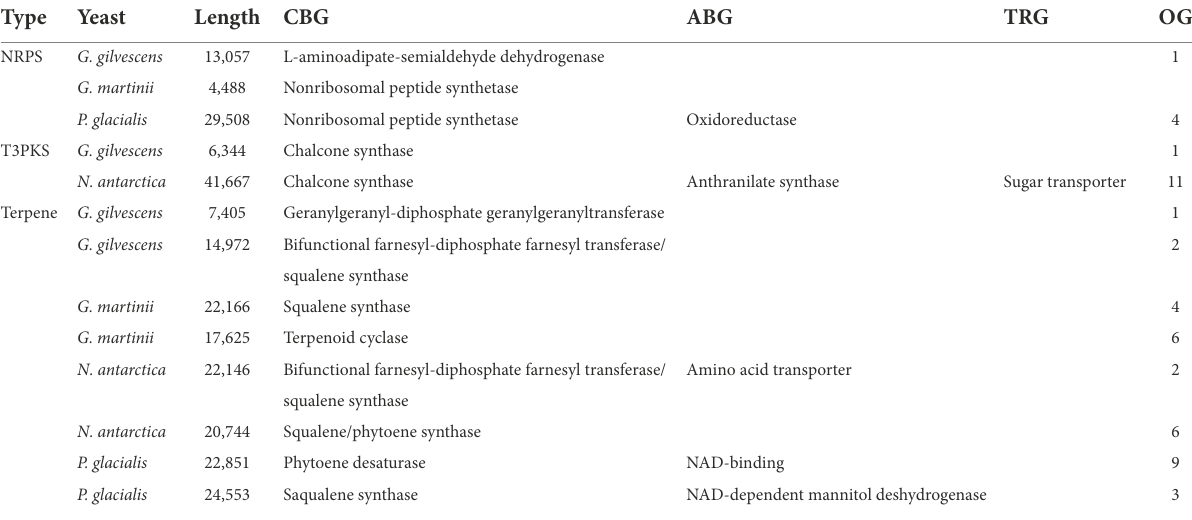
TABLE 1 Secondary metabolite biosynthesis clusters predicted on draft genomes: non-ribosomal peptide synthetase clusters (NRSP), type III polyketide synthase clusters (T3PKS), and terpene.